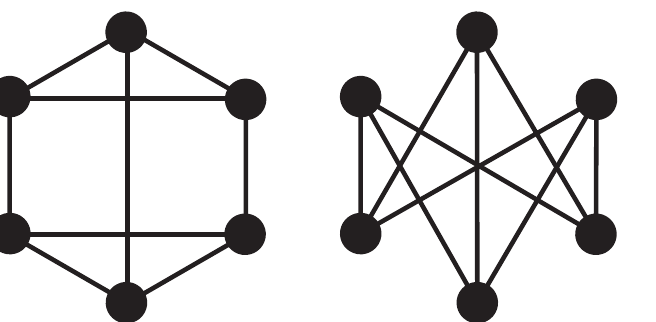
Fig 11. Two 6-graphlets. All of both graphlets ’ vertices have degree 3, and each graphlet has one orbit containing all of its vertices. (A) This graphlet ’ s edges and vertices correspond to the edges and vertices in a triangular prism. (B) The complete bipartite graph K 3,3 .